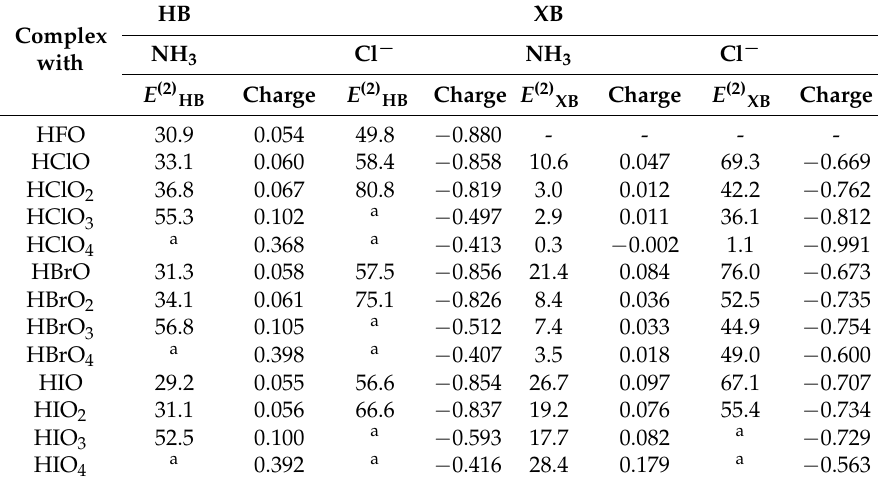
Table 7. Second-order perturbation stabilization energies for the donor-acceptor Lp(N) → σ